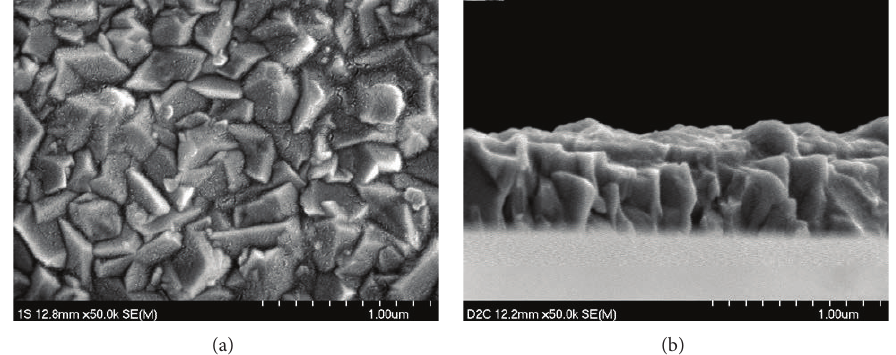
Figure 3: Surface and cross-sectional morphology of TiO 2 films prepared by the CVD methods. Deposition time: 2 hours; deposition temperature: 673 K.